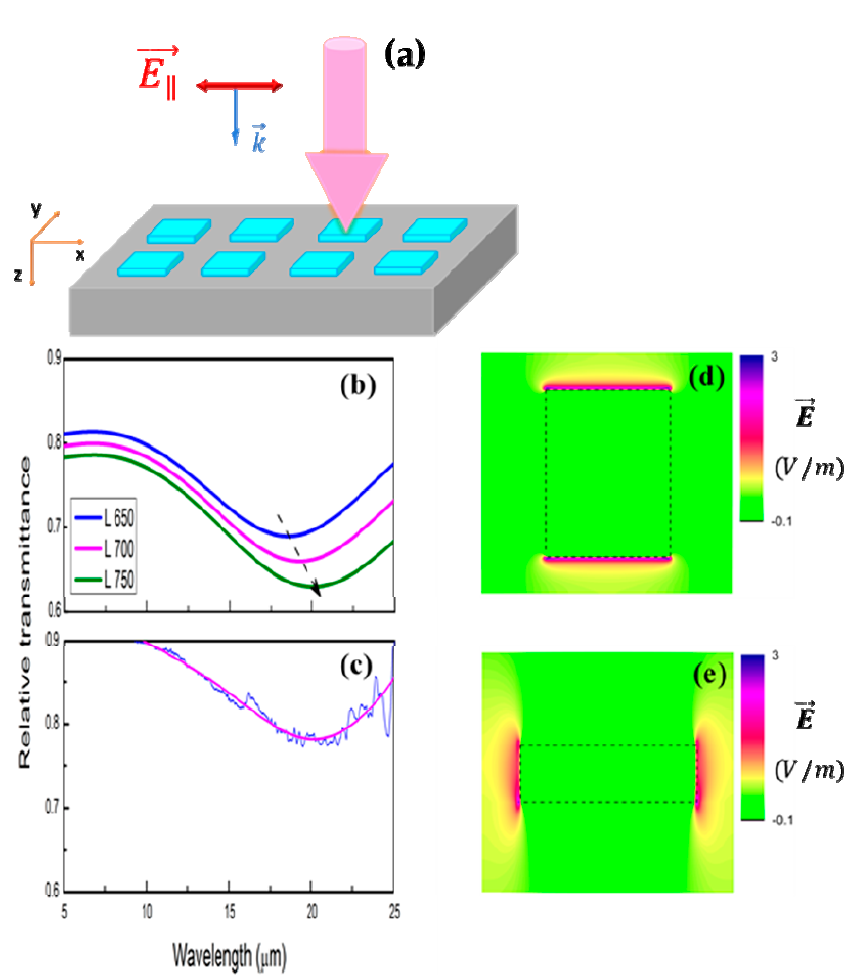
Figure 5. Schematic illustration of the exposure of polarized infrared light with electric field vector parallel to length of nanostrips ( E ) ( a ). Simulation ( b ) and FTIR relative transmittance ( c ) of nanostrips with ( ) polarized incident light. Lengths of nanostrips (L) in simulation were set at 650, 700, and 750 nm, corresponding to blue, pink, and green curves (b). Measured and fitted lines were drawn in blue and pink, respectively (L × W ~ 750 nm × 500 nm) (c). Electric field distribution along x–y and x–z planes of strips ( d , e ).